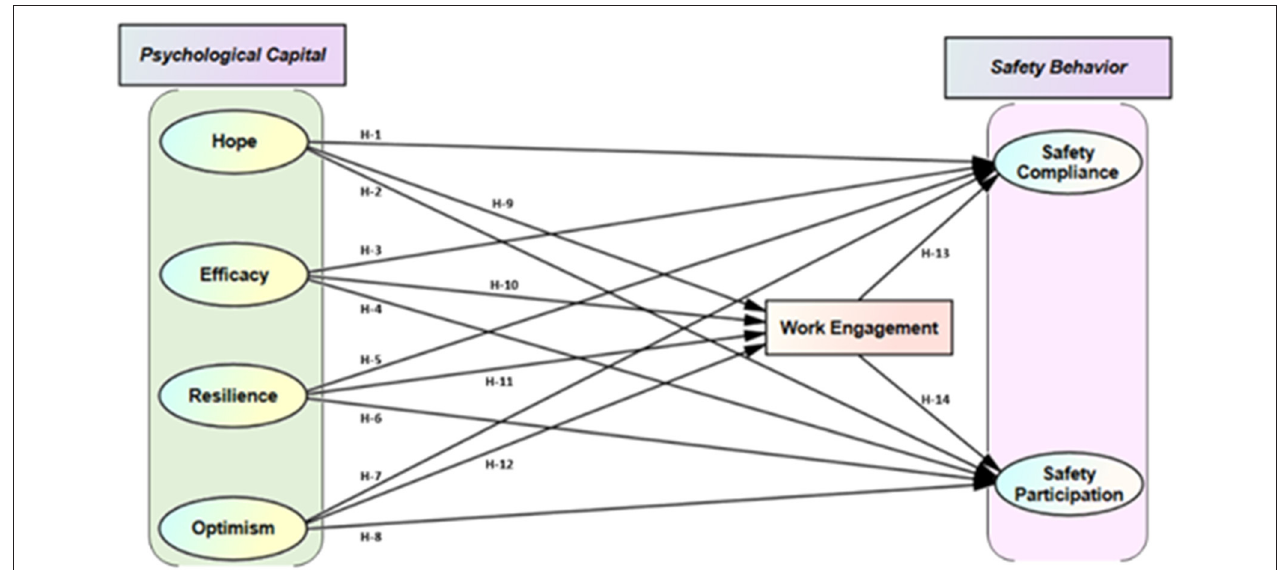
FIGURE 1 | Hypothesized